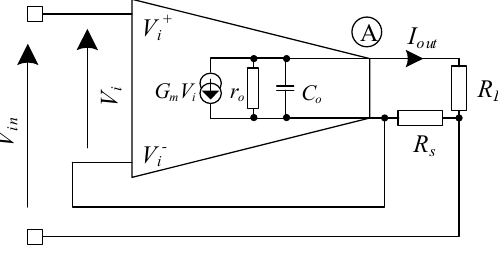
Figure 7. Basic linear feedback current driver [14].